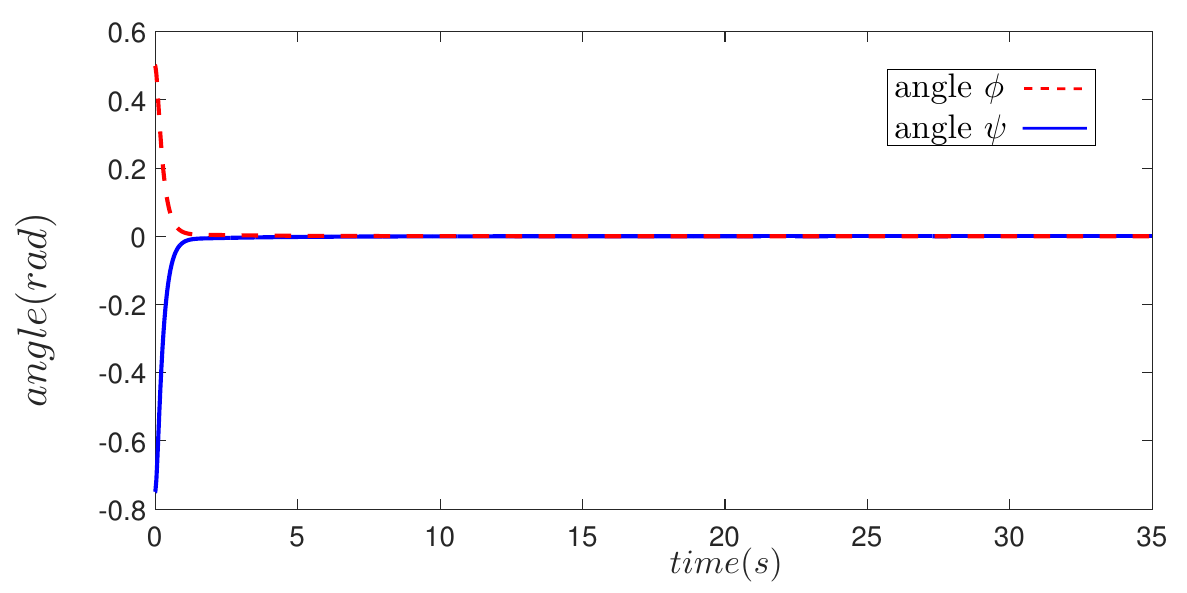
Figure 10. Time evolution of the error angles.